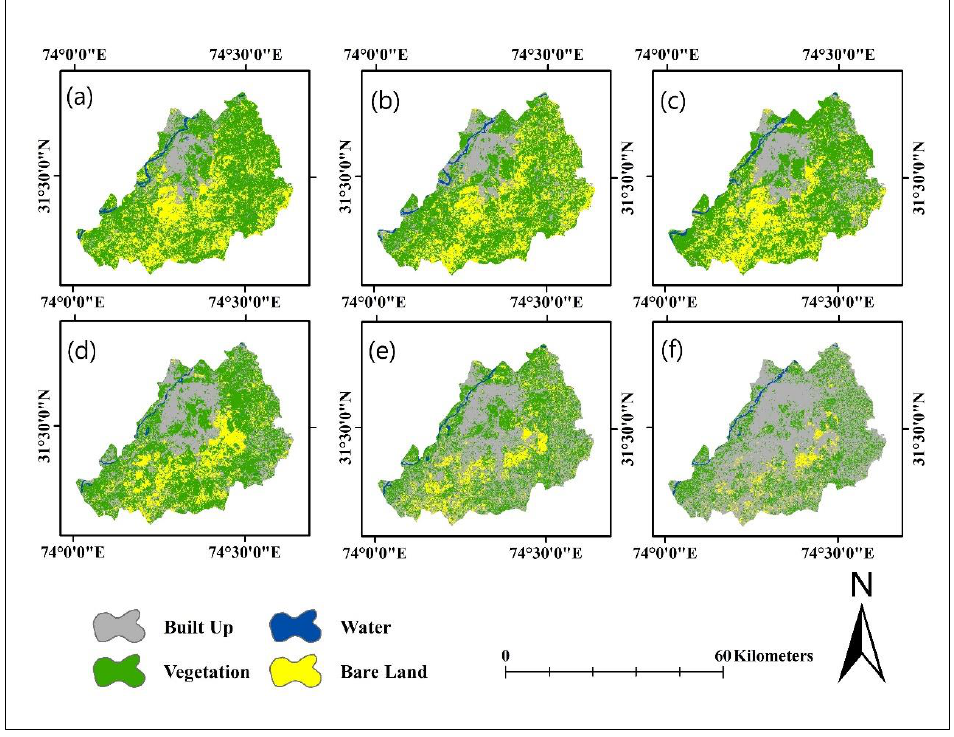
Figure 3. LULC Maps for ( a ) 1992, ( b ) 1996, ( c ) 2000, ( d ) 2008, ( e ) 2014, and ( f ) 2020, showing the spatial distribution and change in different LULC. Table 1. Classification accuracy assessment from 1992 – 2017.